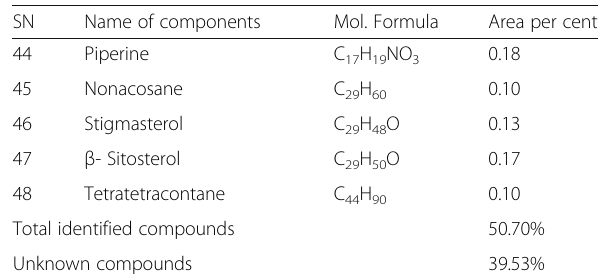
Table 4 Chemical composition of methanolic extract of flowers